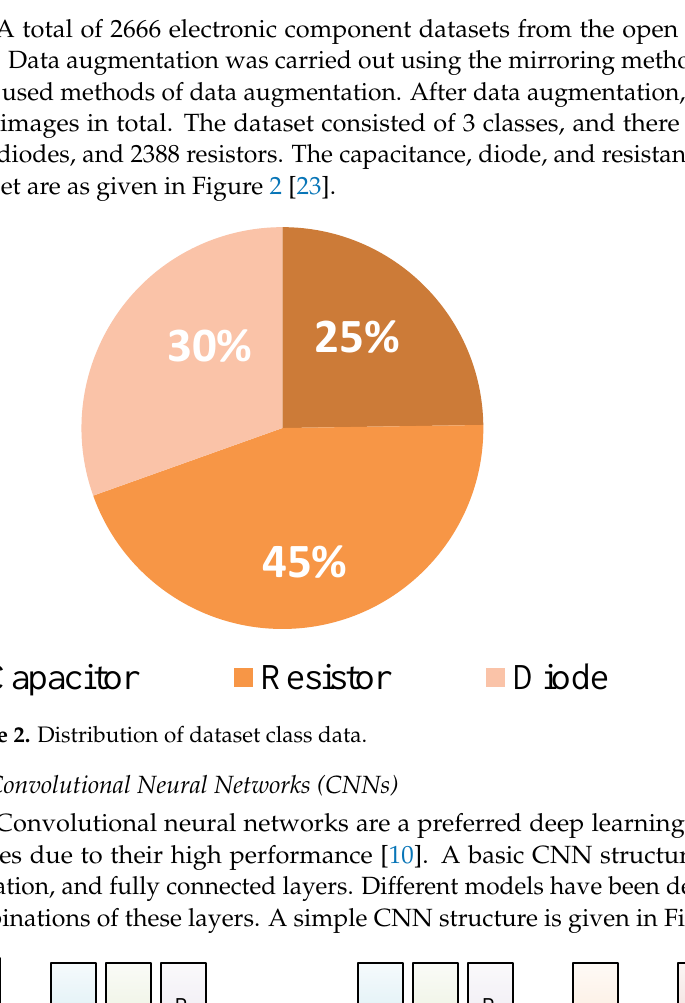
Figure 3. General structure of convolutional neural network. The convolution layer is the first layer in which the image is examined. Here, a filter smaller than the original image wanders over the image and determines its properties.